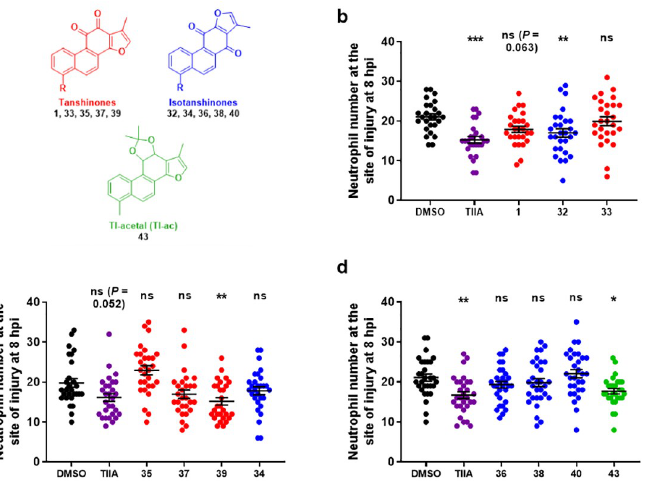
Fig 8. Effects of TI analogues and isomers on resolution of neutrophilic inflammation. a ) Structures of tanshinones (red), isotanshinones (blue) and TI-acetal (green). b )- d ) Tailfin transection was performed on transgenic zebrafish larvae, TgBAC(mpx : GFP)i114 (3 dpf), and at 4 hpi, good responders were subjected to compound treatments: DMSO (0.5%), TIIA 2 (25 μ M) and compounds 1 , 32–40 , 43 (25 μ M). Neutrophil number at the site of injury was assessed at 8 hpi by counting GFP+ cells. Data shown as mean ± SEM; n = 26–30 larvae per group from 4 independent experiments per graph. � P < 0.05, �� P < 0.01, ��� P < 0.001, ns not significant, in comparison to the DMSO control (one-way ANOVA with Dunnett’s multiple comparison